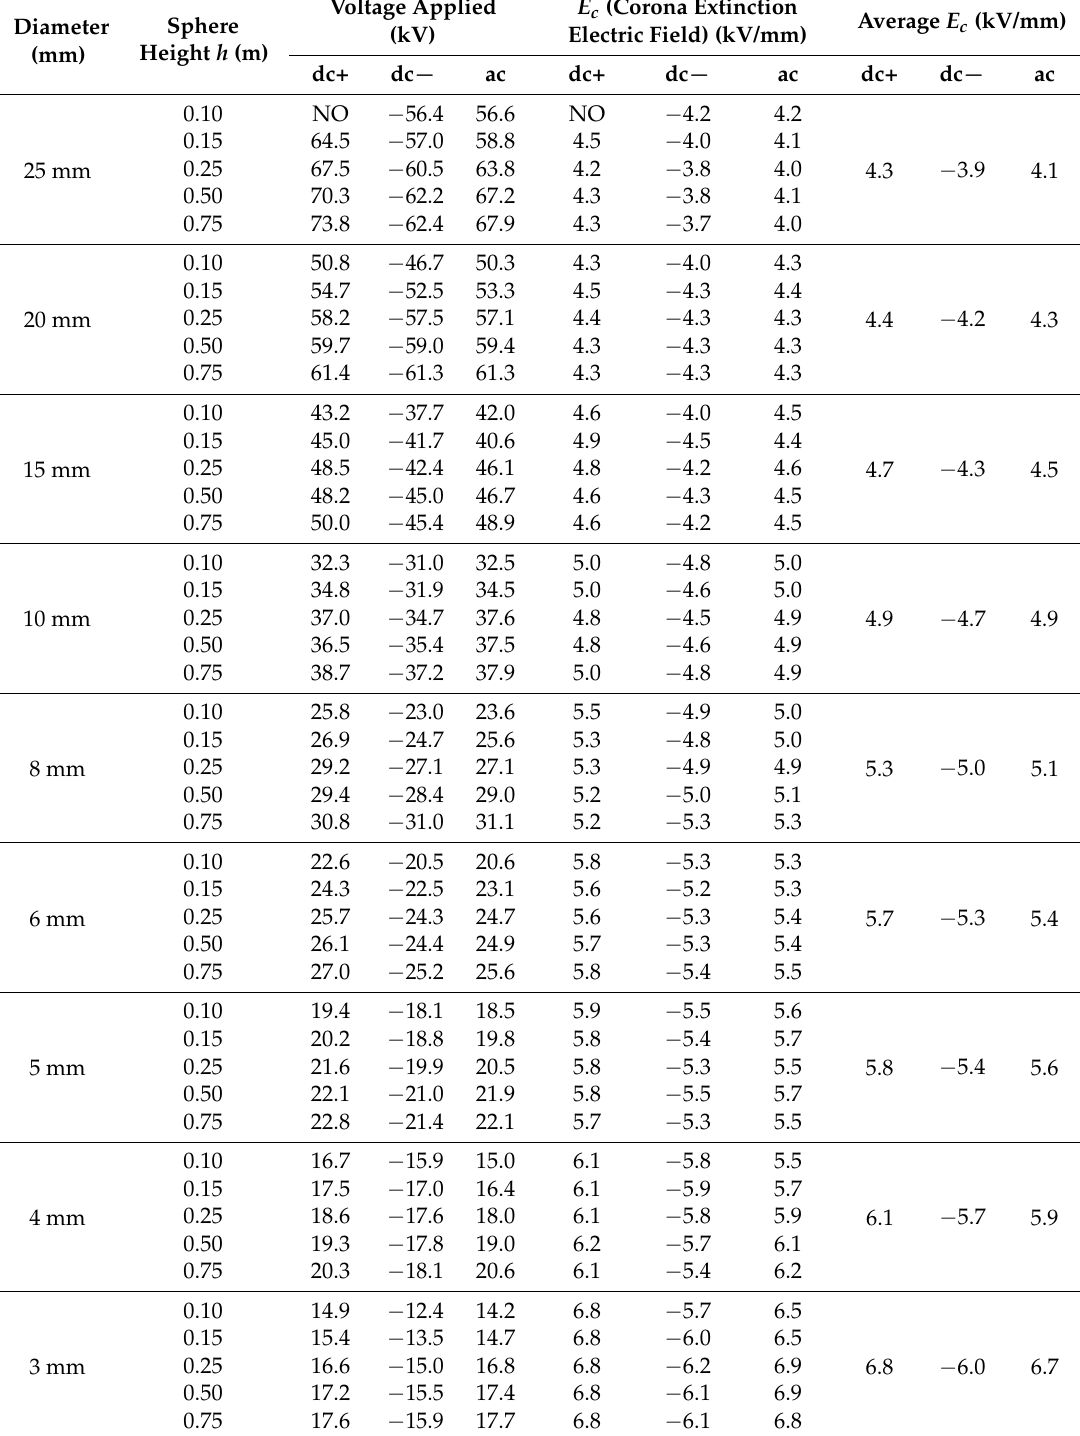
Table 3. Summary of the experimental visual corona extinction voltage and the electric field strength obtained by means of FEM simulations under 50 Hz ac (peak values), positive polarity dc and negative polarity dc supply. ac: alternating current, dc: direct